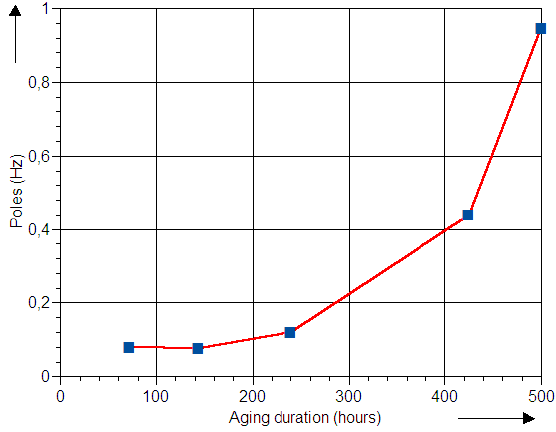
Figure 7. Poles evolution as a function of thermal ageing